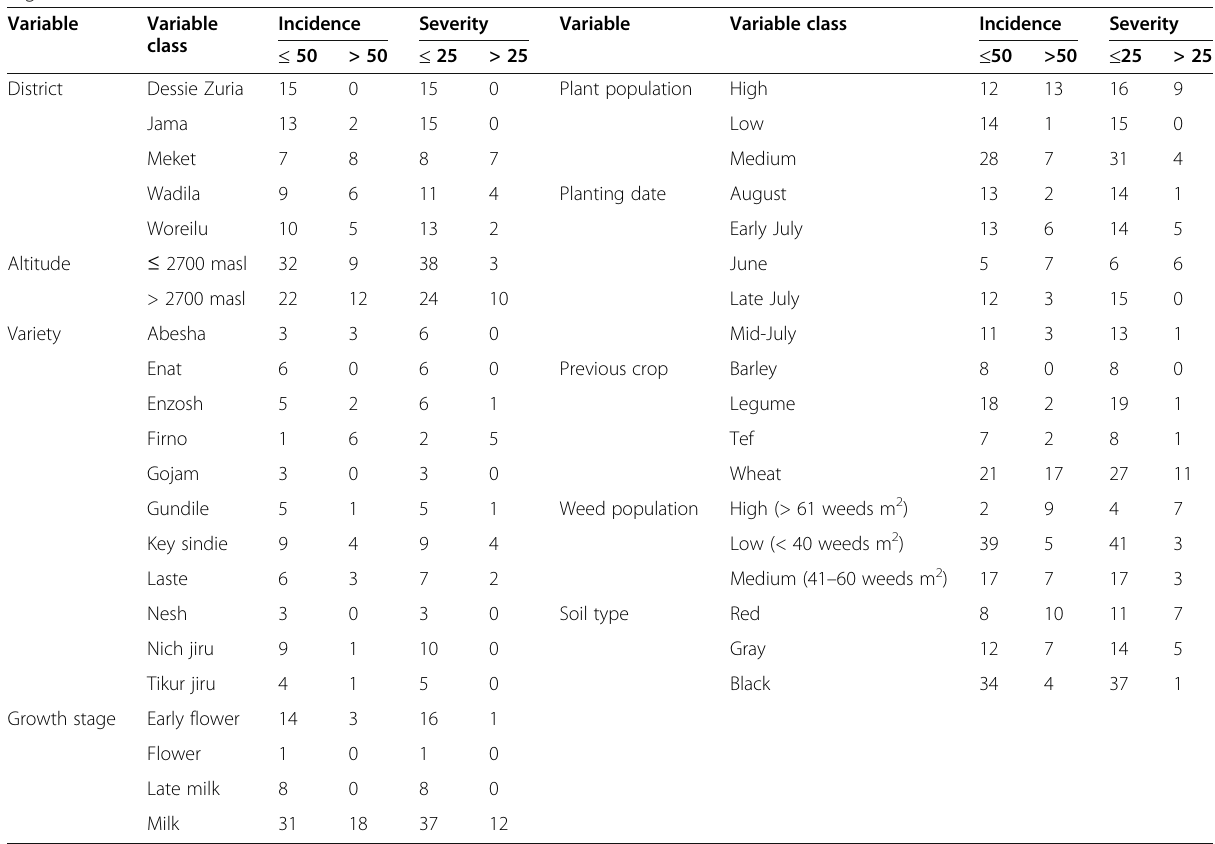
Table 1 Independent variables by disease contingency for logistic regression analysis of durum wheat septoria tritici blotch in the highlands of Wollo